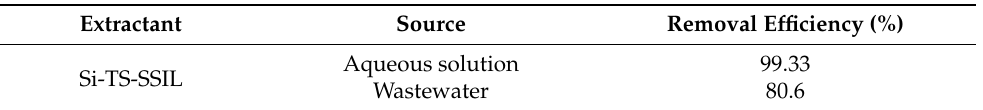
Table 6. Comparison of removal efficiency for Pb(II) removal using Si-TS-SSIL extractant from aqueous solution and wastewater containing 10 mg L − 1 of Pb(II)